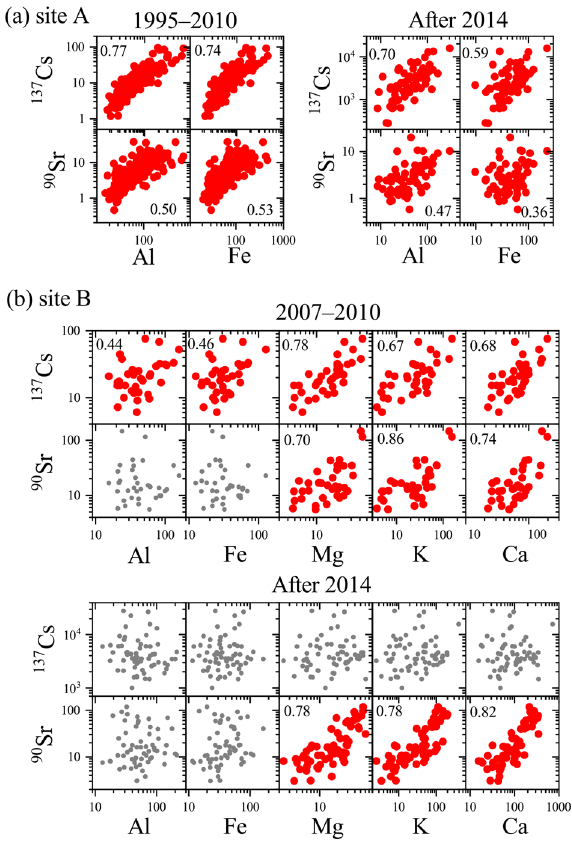
Figure 4. Correlations between radionuclides and stable elements at sites ( a ) A and ( b ) B. The units for 90 Sr and 137 Cs are mBq m −2 , and those for the stable elements are mg m −2 . The red points reveal that the correlations are significant ( p < 0.05) based on the correlation coefficient values. The gray points show that the correlations are not significant ( p ≥